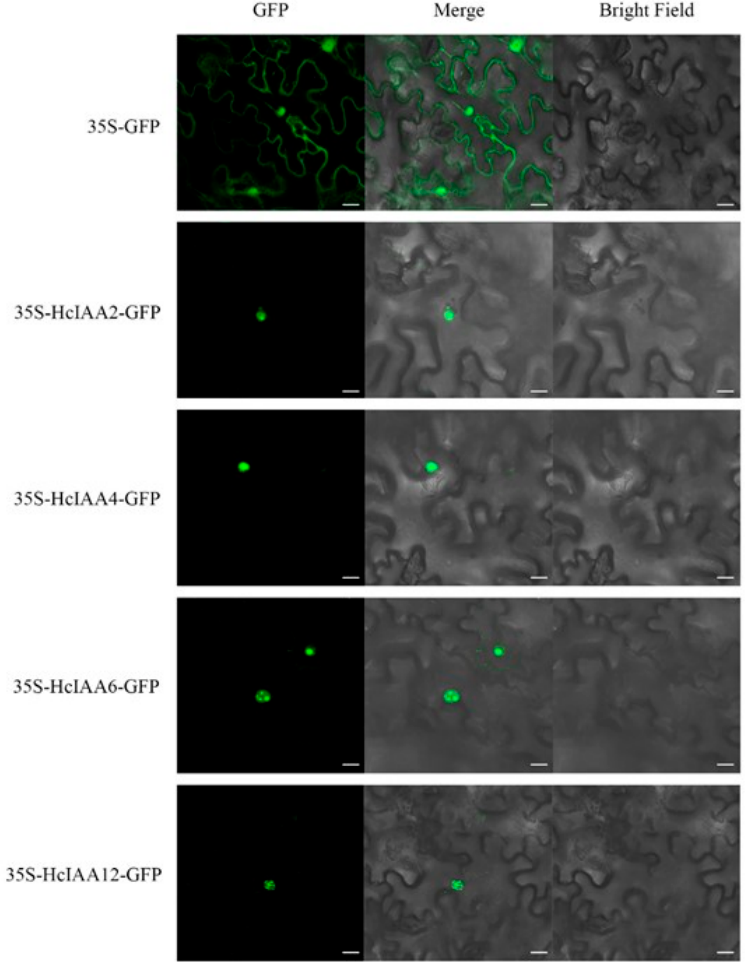
Figure 8. Subcellular localization of HcIAA2, HcIAA4, HcIAA6 and HcIAA12 proteins. HcIAA2-GFP, HcIAA4-GFP, HcIAA6-GFP and HcIAA12-GFP fusion proteins were transiently expressed in N. benthamiana leaves, and their subcellular localization was examined by confocal laser scanning microscopy. The merged pictures of the green fluorescence channel (left panels) and the corresponding bright field (right panels) are shown (middle panels). The scale bar indicates 20 μ m.